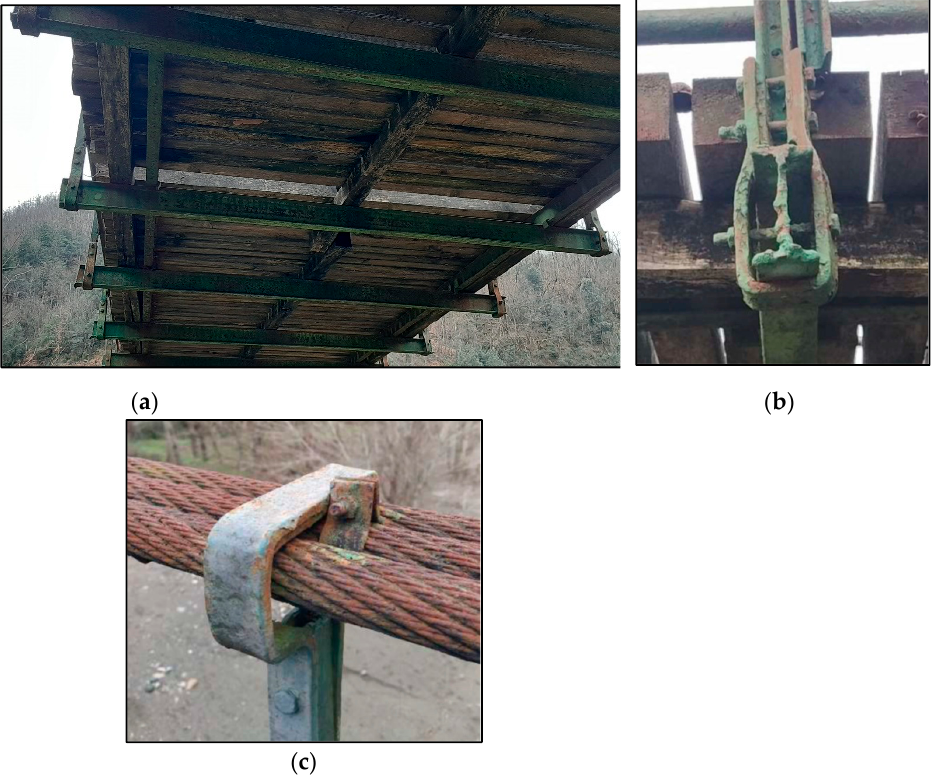
Figure 3. Details of the bridge deck ( a ), connections between the hanger and deck transversal beam ( b ) and between the hanger and main cable ( c ).